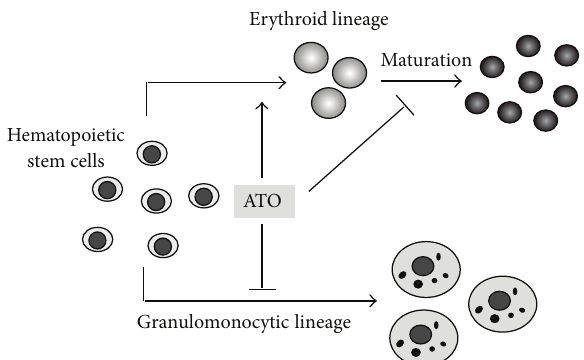
Figure 3: A diagram summarizing the major findings of this study. We provided the first evidence showing that ATO could prime human hematopoietic progenitor cells for an enhanced erythroid differentiation, at the expense of decreased granulomonocytic differentiation.